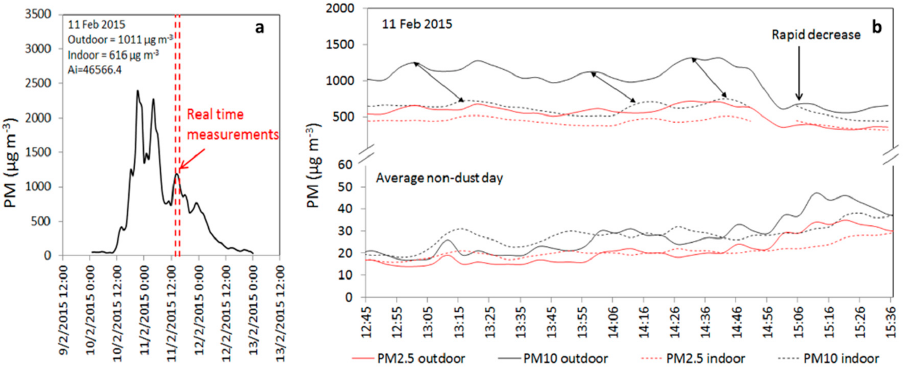
Figure 4. ( a ) The recorded PM10 concentrations by the environmental monitoring station in Beer-Sheva during the dust storm in 11 February 2015. The average PM 10 concentrations and storm intensity (AI) are presented.) ( b ) Real-time measurements of hourly indoor and outdoor variations in PM 10 and PM 2.5 recorded ( n = 30) in the houses in Beer Sheva compared with the concentrations recorded in the houses during non-dust days. The arrows between the PM 10 curves represent the time lag between the indoor and outdoor concentrations.